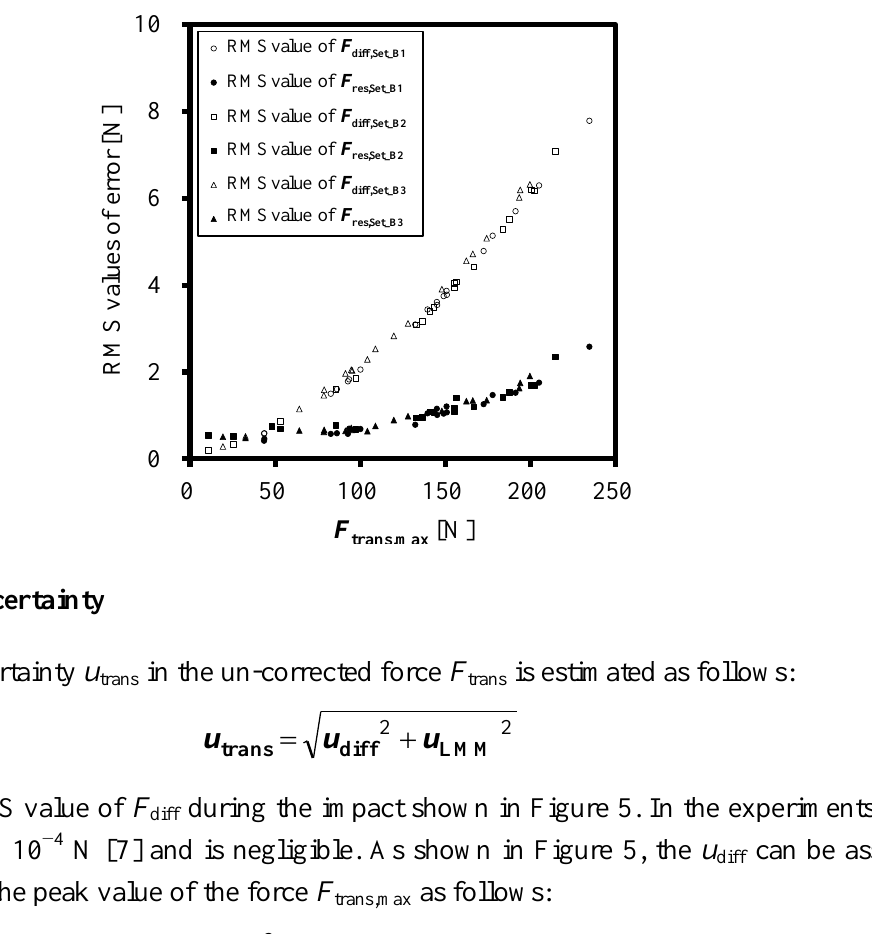
= F − F and F = F − F about other diff trans mass res corrected mass